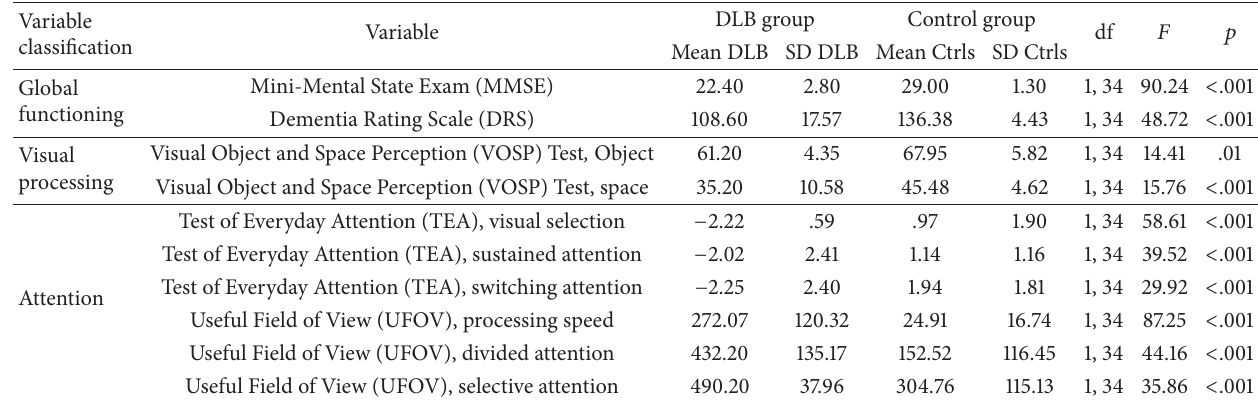
Table 2: Differences in cognitive performance between participants with Dementia with Lewy Bodies (DLB) and controls. Variable classification Global functioning Visual processing